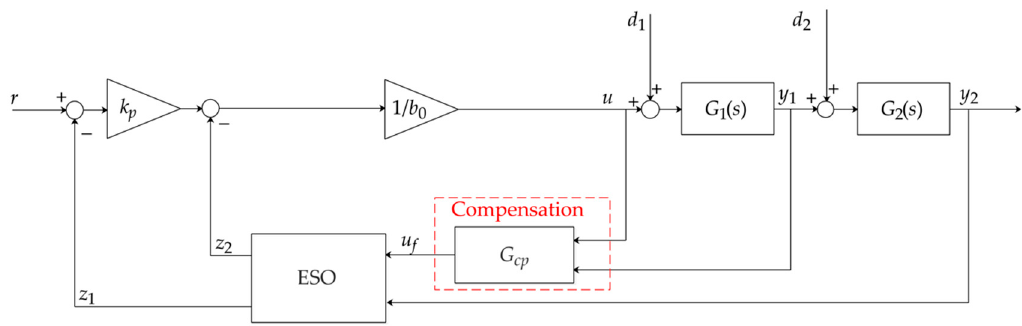
Figure 4. The hybrid ADRC designed for an SST system.